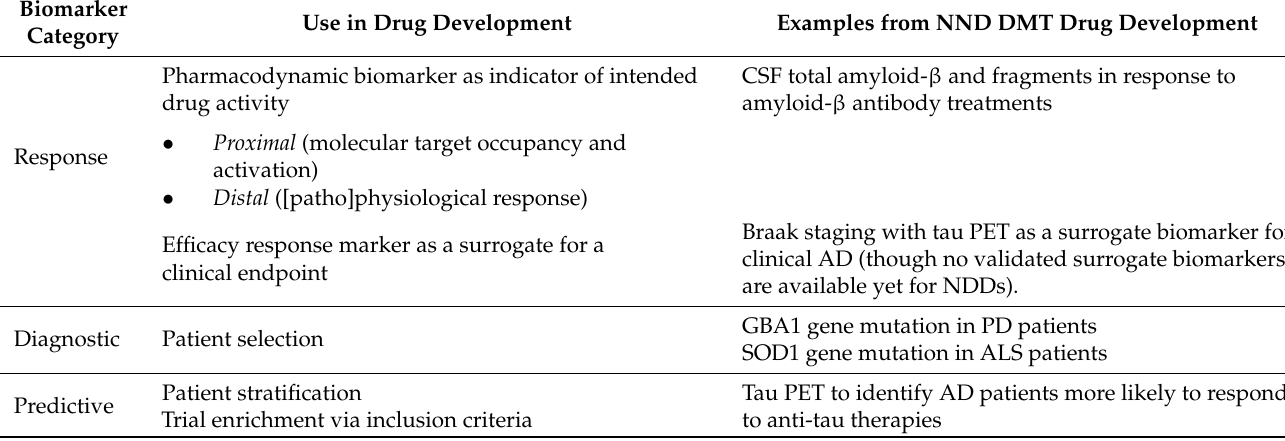
Table 1. Biomarker categories and examples of use in NND DMT drug development (adapted from Cummings and Amur et al.